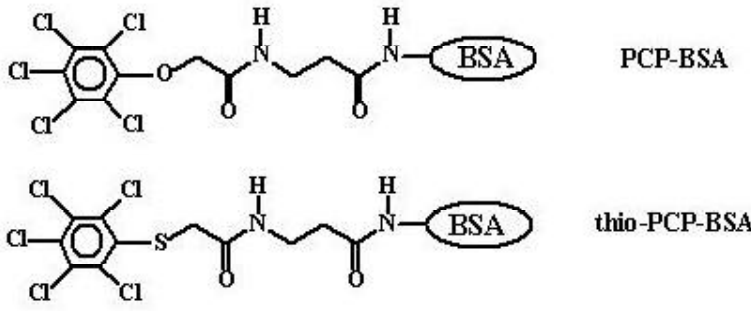
FIGURE 1 . Structure of immunogens; the carrier protein is bovine serum albumin (BSA).